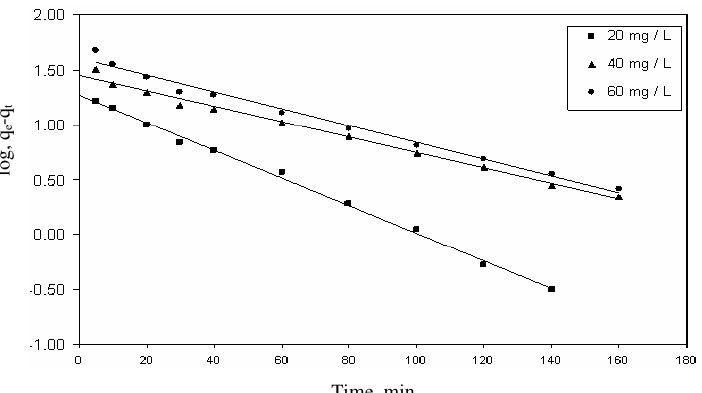
Figure 2a. Pseudo first order plot for Reactive Red 2 removal – initial dye concentration variation